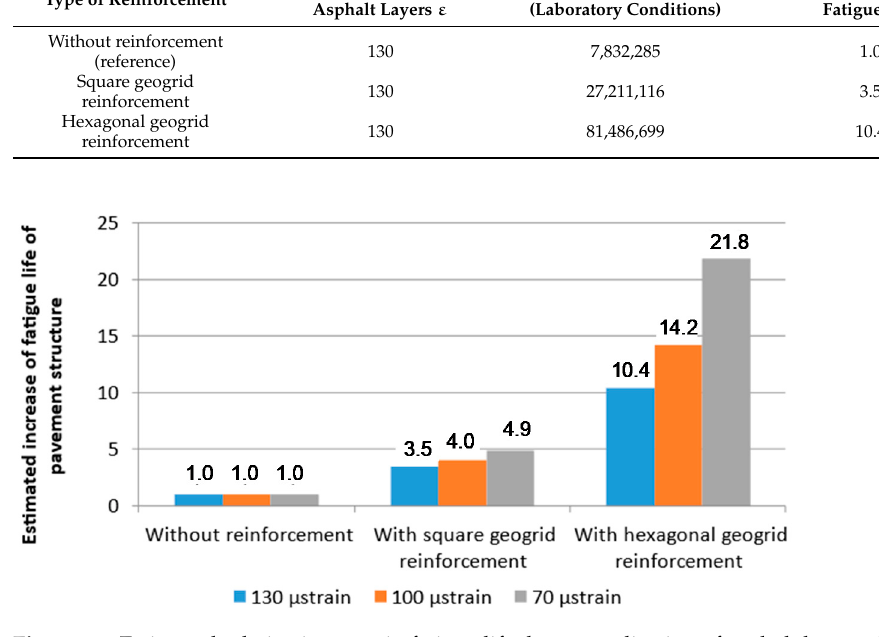
Figure 16. Estimated relative increase in fatigue life due to application of asphalt layer reinforcement at chosen levels of strain.